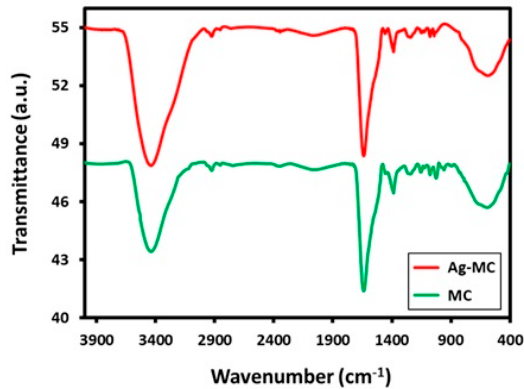
Figure 2. FT-IR spectra of pure Myrtus communis L. plant extract (MC) and green synthesized silver nanoparticles using Myrtus communis L. extract (Ag-MC).